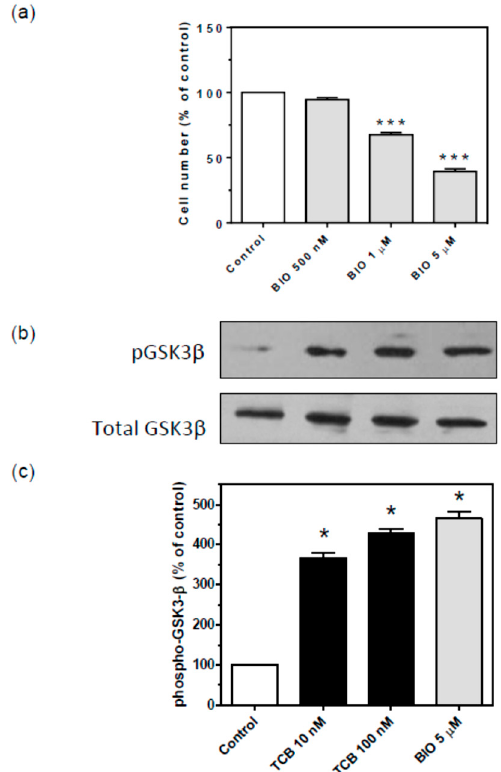
Figure 12. Effect of GSK-3 β inhibition on cell proliferation and GSK-3 β Ser9 phosphorylation of LLC-PK1 cells. Serum-starved LLC-PK1 cells were treated with 0.5, 1, and 5 μ M BIO (GSK-3 β inhibitor) in 2.5% FBS for 72 h ( a ), and 10 and 100 nM TCB and 5 μ M BIO for 15 min ( b , c ). Trypan blue-free viable cells were counted in Neubauer chamber ( a ). Representative western blots of phospho- and total GSK-3 β ( b ) and relative optical density quantification in ( c ). Data are the mean ± SEM of at least three independent experiments. * p < 0.05; *** p < 0.005 vs. control.